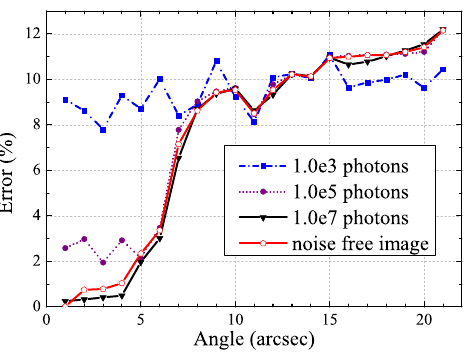
Figure 6. Error on the estimation of the PSF model in the case of a noise free image, and in the cases of photon noises with 10 3 , 10 5 , and 10 7 photons in the whole image, respectively.